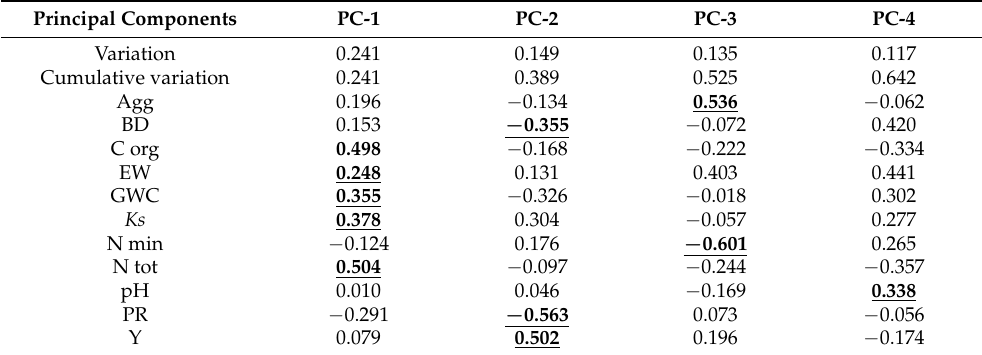
Table 5. Results of principal component analysis under different treatment combination in different years. Bolded factor loads were considered as high. Bolded and underlined factor loads determined for each variable were those the PC considered in the RSI calculation. The weighting factor ( PW ) for each variable was equal to the variation explained by the PC selected (Agg—aggregate stability; BD—bulk density; C org—soil organic carbon; N tot—soil total nitrogen; GWC—gravimetric water content; PR—penetration resistance; Ks —saturated hydraulic conductivity; EW—earthworm density; N min—mineral